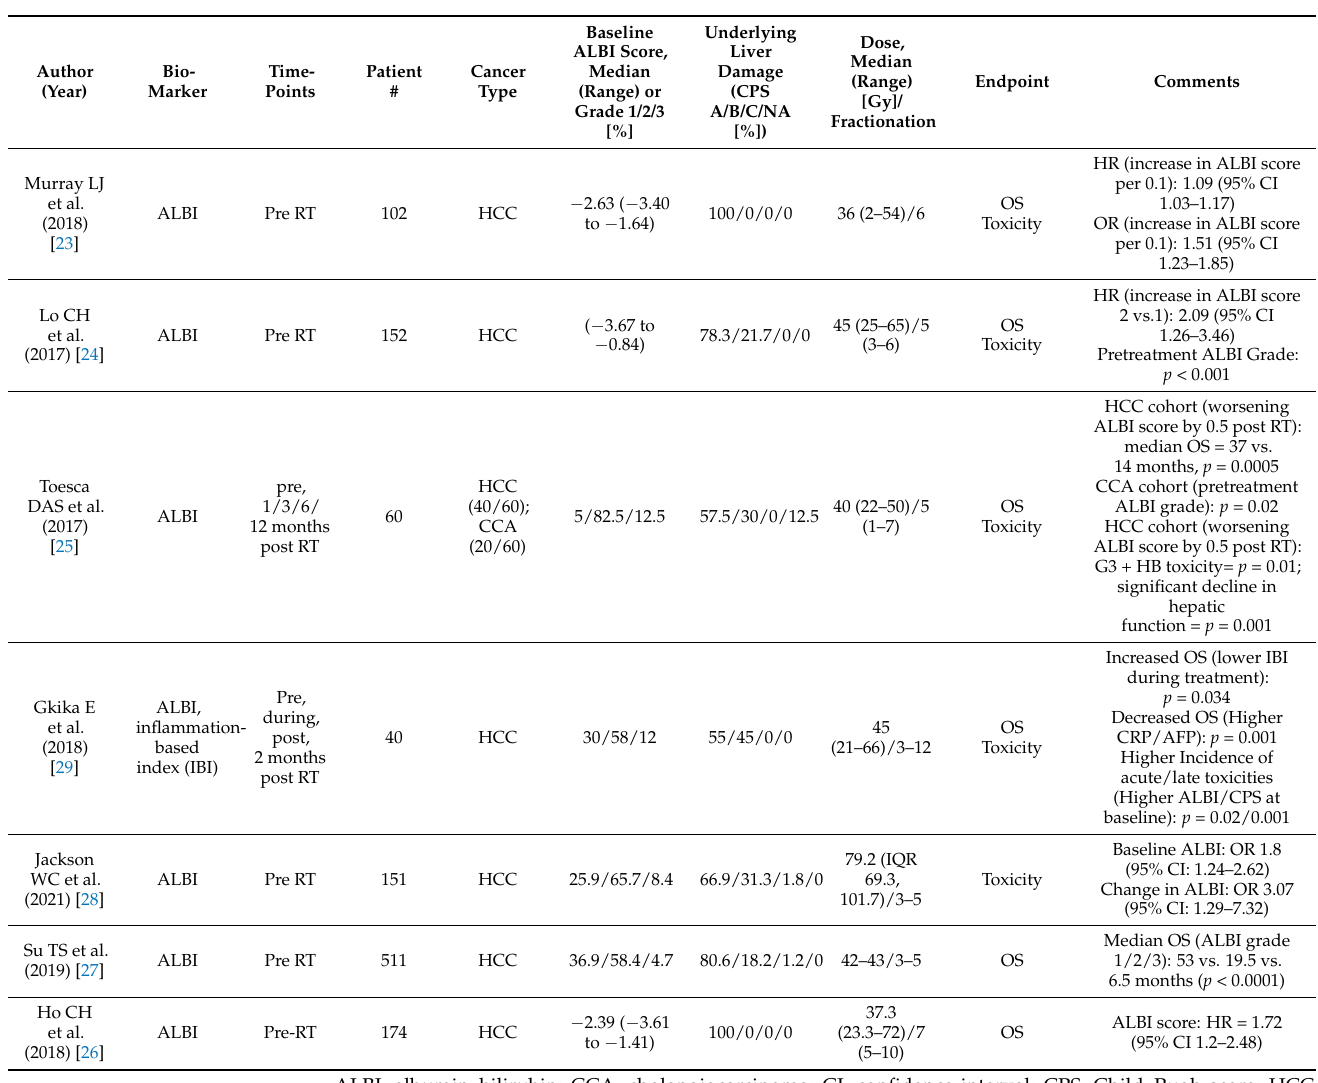
Table 1. Albumin–bilirubin (ALBI) grade as biomarker of radiotherapy outcome in liver cancer